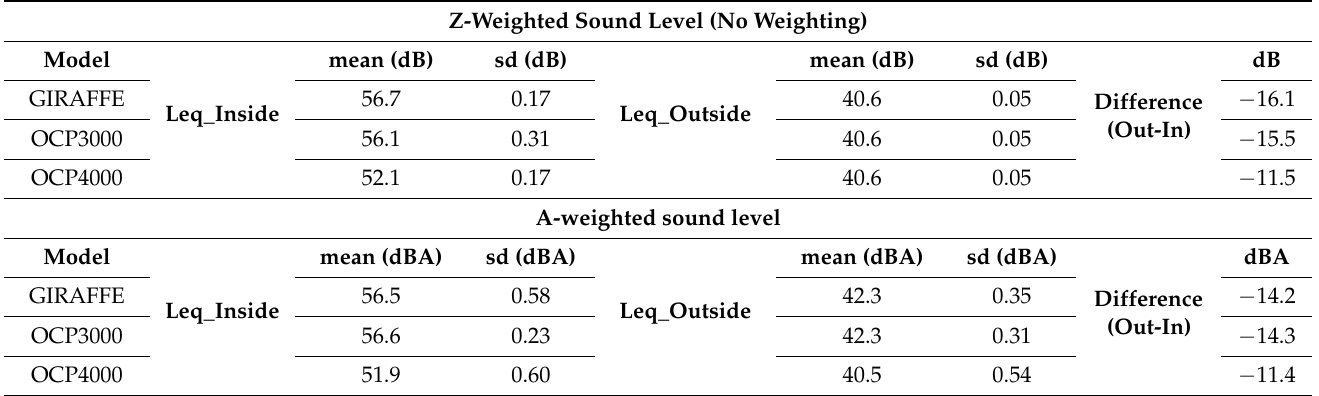
Table 2. The overall noise level inside and outside the incubators (Incubators on). Z-Weighted Sound Level (no weighting)